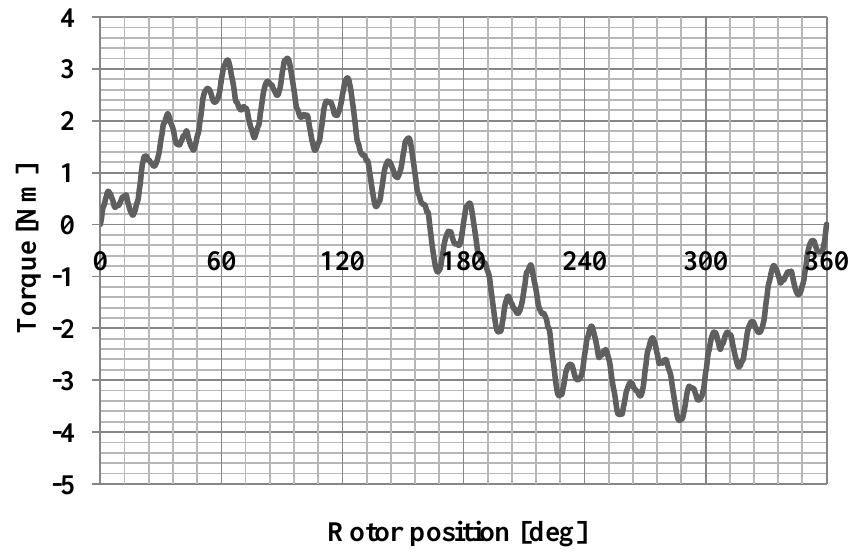
Figure 8. The characteristic of the static